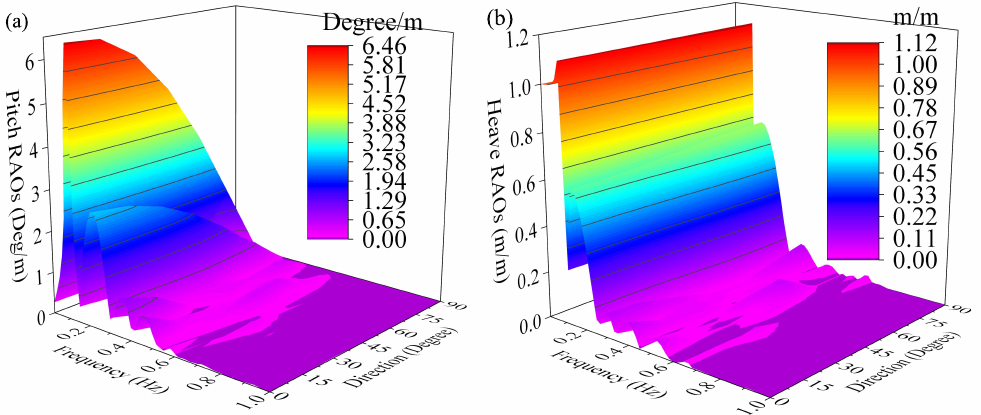
Figure 9. 3D surface plot between the RAOs and the two interacted variables of wave frequencies and wave directions. ( a ) For pitch RAOs; ( b ) For heave RAOs.